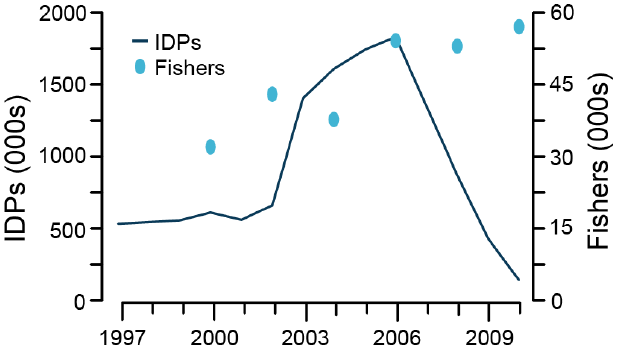
Fig. 6 . The number of fishers increased in Uganda at the same time internally displaced people (IDPs) were increasing. The number of fishers (from biennial frame surveys) jumped between 2004 and 2006 (22% per year) as IDPs in Uganda peaked, against a general population increase of 6.6% of people living within five km of the lake shore.